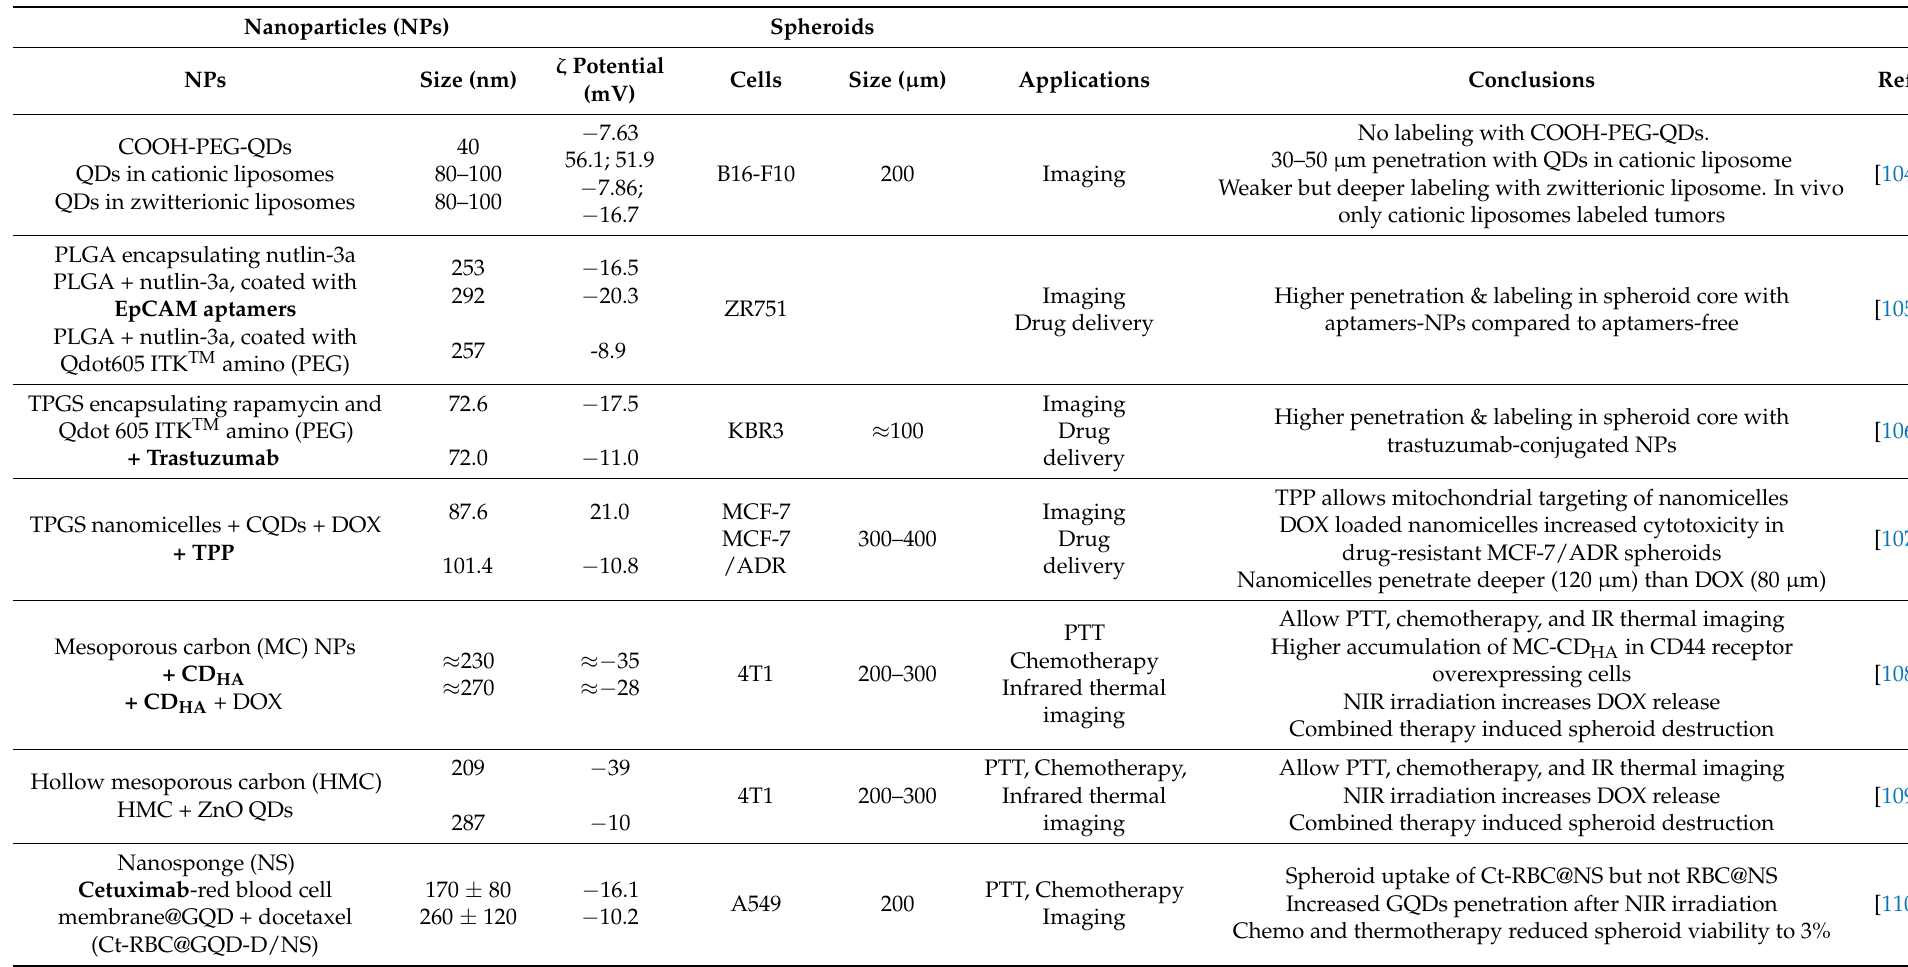
Table 3. Main parameters and conclusions reported using QDs as part of nanoparticular complexes in spheroid